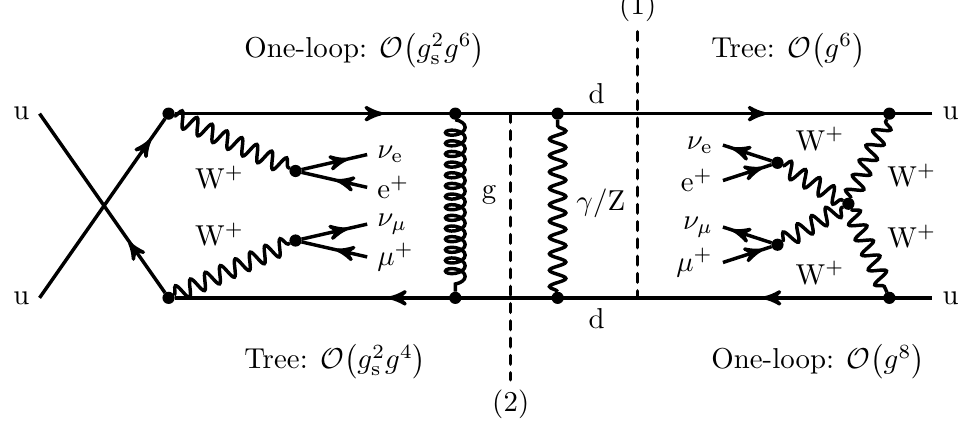
(cid:22) + (cid:23) (cid:22) e + (cid:23) e !